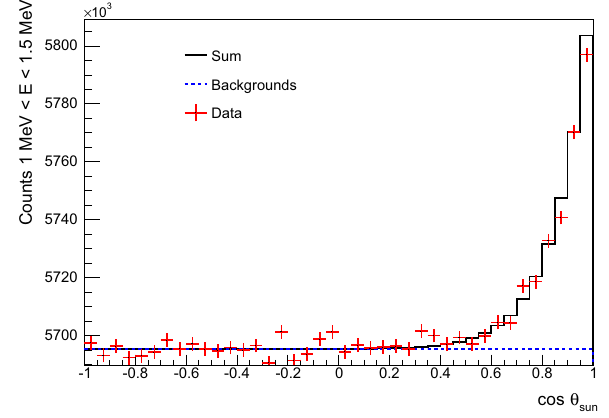
Fig. 4 Projectionoftwodimensionalfitincos θ (cid:3) forenergiesbetween 1 and 1.5 MeV for a randomly generated fake dataset with the baseline detector configuration and background